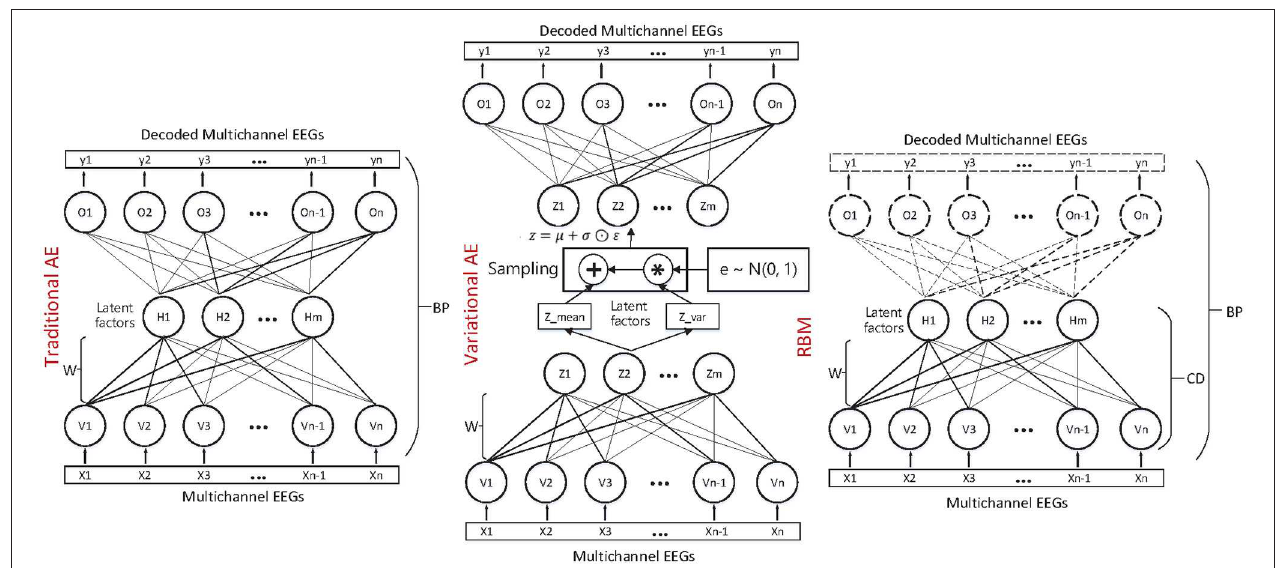
FIGURE 2 | The neural network-based multichannel EEG fusion and latent factor decoding